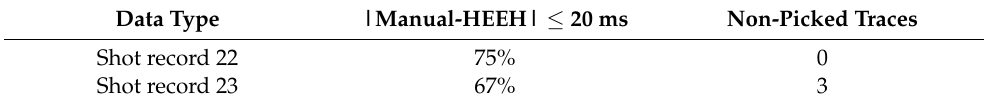
Table 3. The percentage of the number of HEEH picks within 20 ms for the real